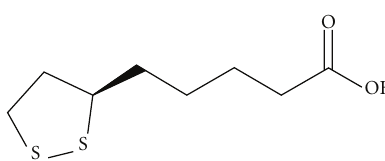
Figure 1: The chemical structure of α -lipoic